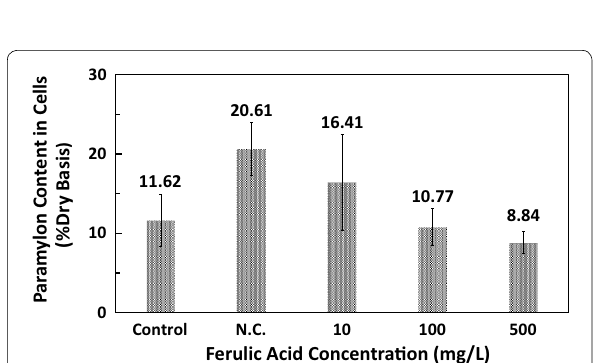
Fig. 5 Paramylon content in Euglena gracilis cells cultured with differ‑ ent concentrations of ferulic acid. N.C. negative control